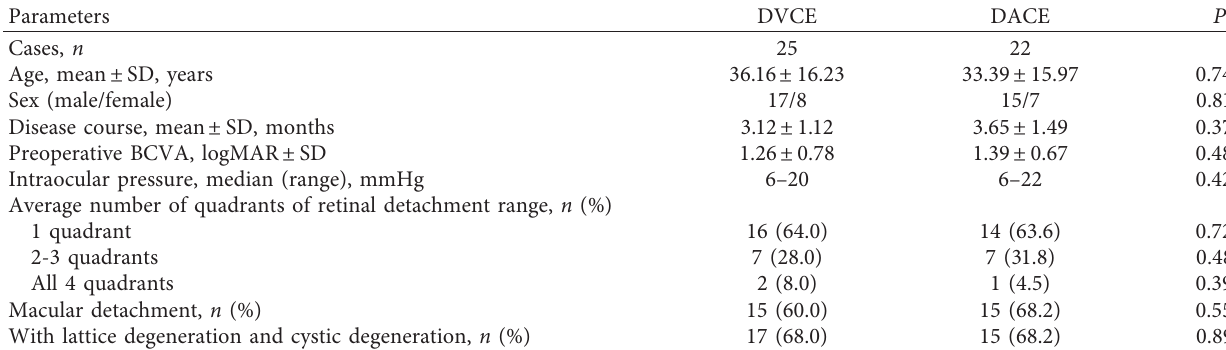
Table 1: Characteristics of the patients.